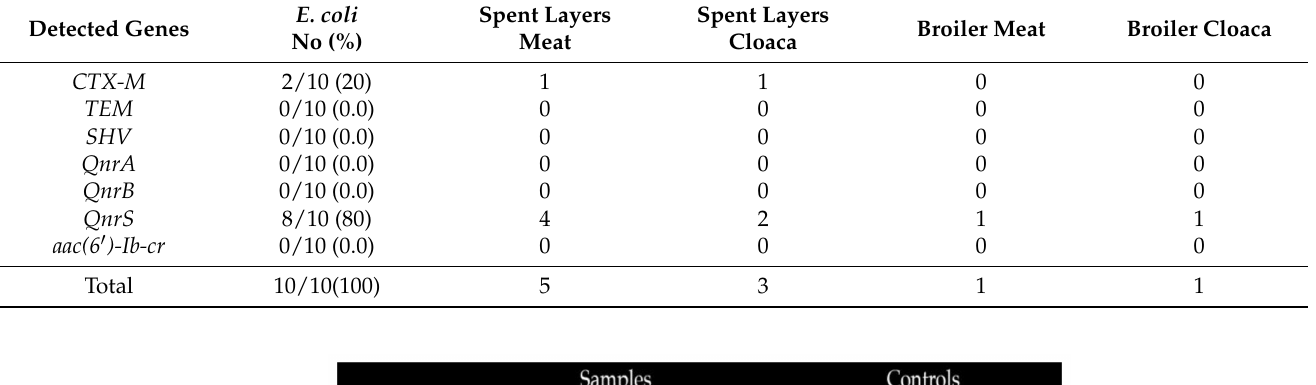
Table 5. Distribution of ESBL- and PMQR-encoding genes by PCR ( n = 10).